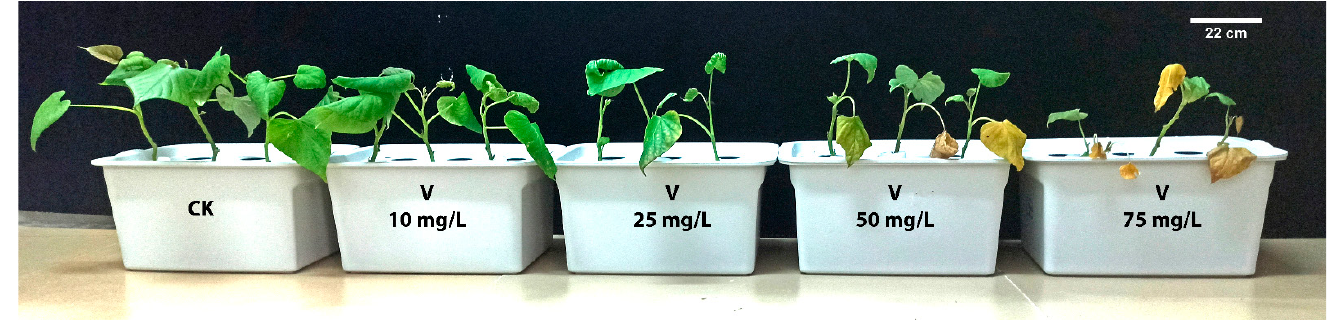
Figure 1. The influence of various V treatments on the growth of sweet potato. Table 1. The influence of various V treatments on growth parameters of sweet potato.